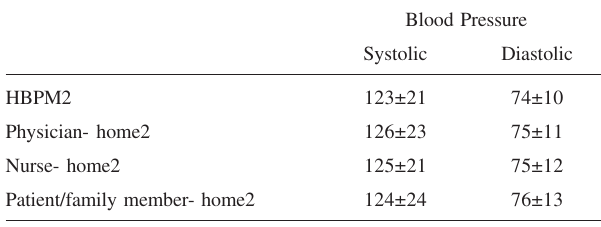
Table 1 - Blood pressure measurements (mean ± standard deviation, mm Hg) taken by a physician, a nurse and the patient/family member during a special home visit (Home 2) and HBPM2.